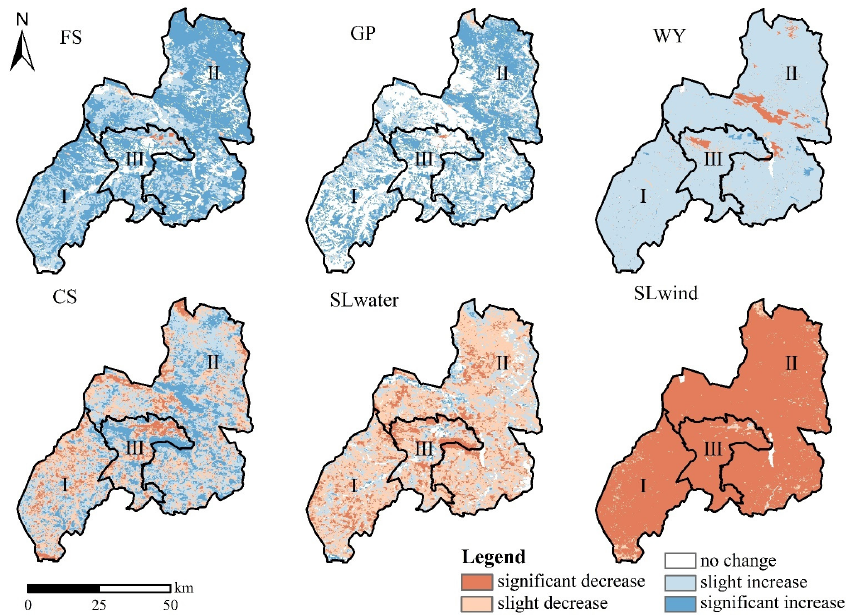
Figure 4. Spatial patterns of the six key ESs change trends and significance levels ( p < 0.05) from 2000 to 2017. Zone I: the agricultural advantage zone (agro-zone), Zone II: the pastoral advantage zone (pastoral zone), Zone III: the semiagricultural and semipastoral zone (agro-pastoral zone). FS: food supply, GP: grass production, WY: water yield, CS: carbon sequestration, SLwater: soil water erosion, and SLwind: soil wind erosion. The spatial patterns of the ESs in Duolun County exhibited regional heterogeneity (Figure 5), and the spatial distribution patterns of each ES remained stable (Figures S1– S6). Taking 2017 as an example (Figure 5), FS shows a decreasing trend from the agro- zone to the pastoral zone (Figure 5a). In contrast, GP and CS show an opposite pattern compared with FS, i.e., the high supply was concentrated in the northern and eastern areas of the pastoral zone (Figure 5b,d). The spatial distribution of WY patterns changed slightly in different years, but most of the high-value zones were distributed in the agro-pastoral zone, with a few in the northern and eastern parts of the pastoral zone (Figure 5c). SLwater showed a decreasing characteristic from southwest to northeast, with most of the higher areas concentrated in the agro-zone and the eastern part of the pastoral zone, whereas SLwater was less concentrated in the agro-pastoral zone (Figure 5e). Although the SLwind has decreased significantly over the past 18 years (Figure S6), the relatively higher areas